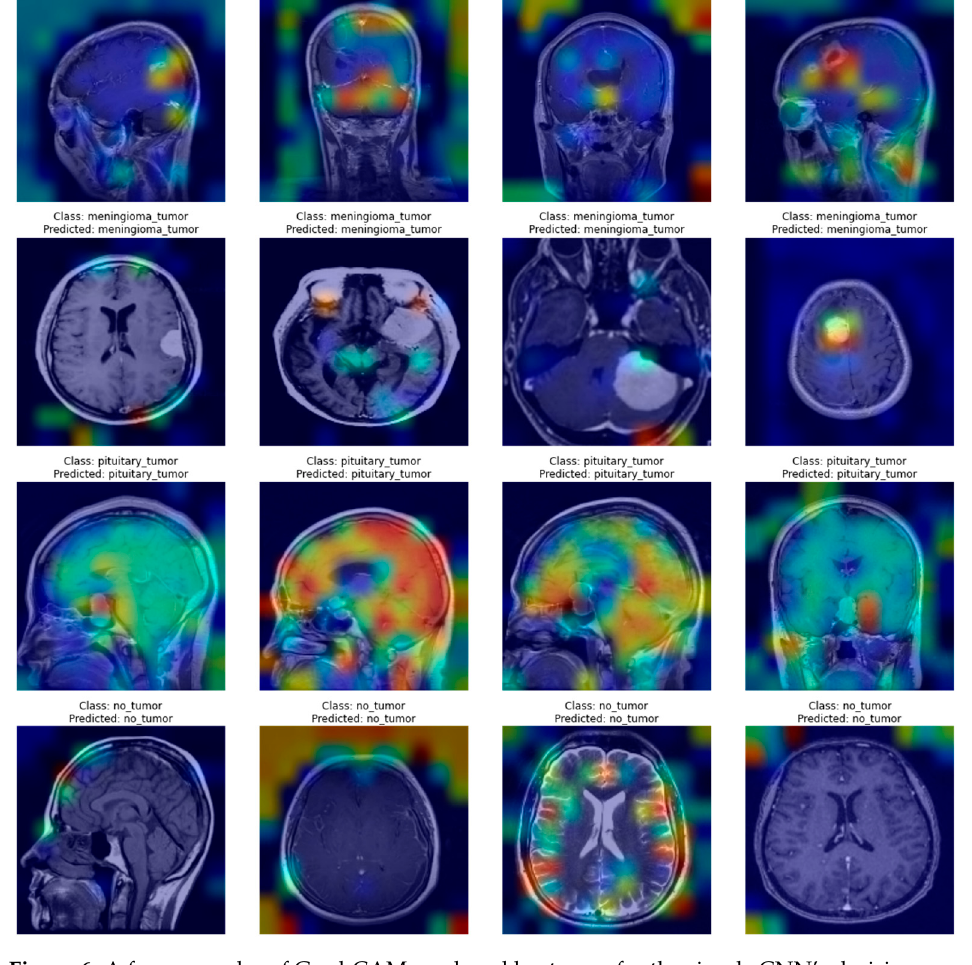
Figure 6. A few examples of Grad-CAM produced heatmaps for the simple CNN’s decisions.